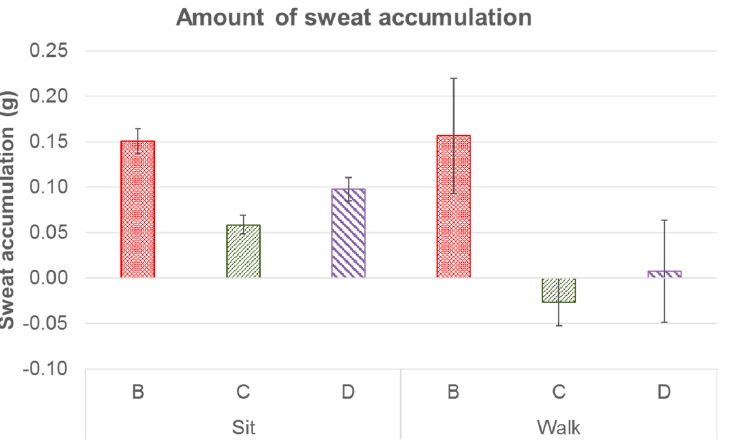
Figure 8. Amount of sweat accumulated for three footwear conditions during sitting and walking, where B: leather sports shoes, C: mesh sports shoes, and D: closed-toe slipper. where B: leather sports shoes, C: mesh sports shoes, and D: closed-toe